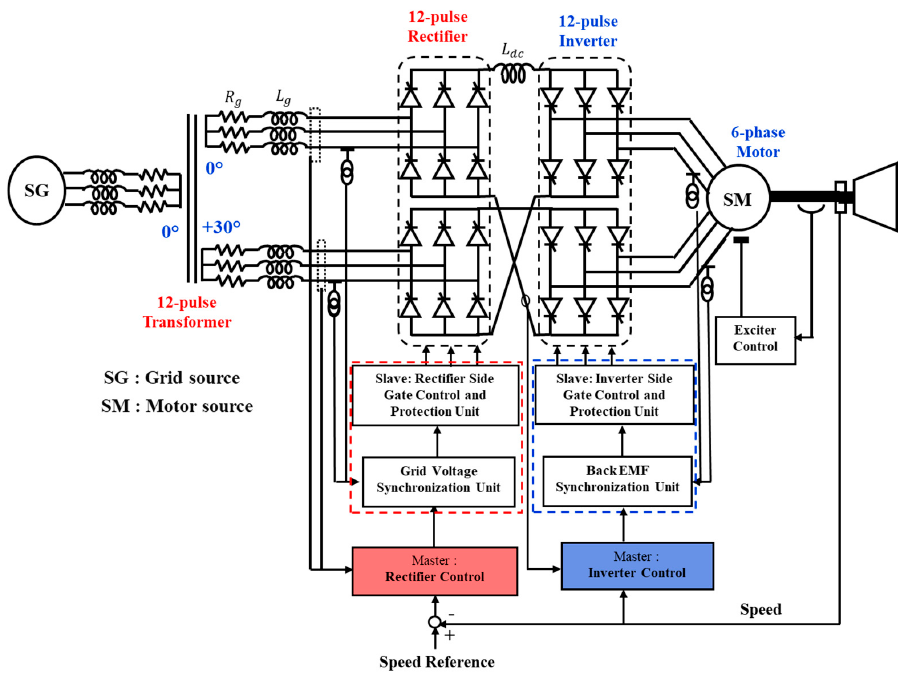
Figure 13. Simplified representation of the simulated 12/12-pulse LCI system with a 6-phase syn- chronous motor.